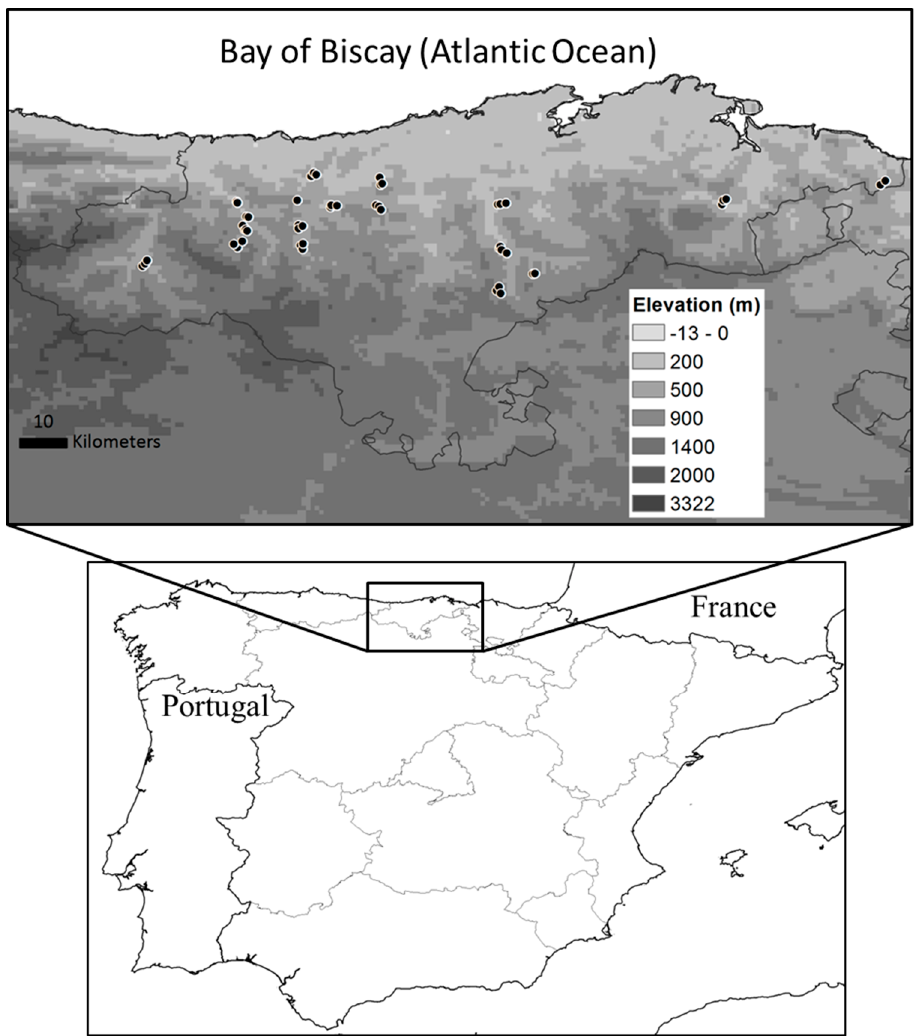
Figure 2. Map of Cantabria (Spain) ( lower map) and the location of the surveyed sites in Cantabria overlaid on an elevation map ( upper map).